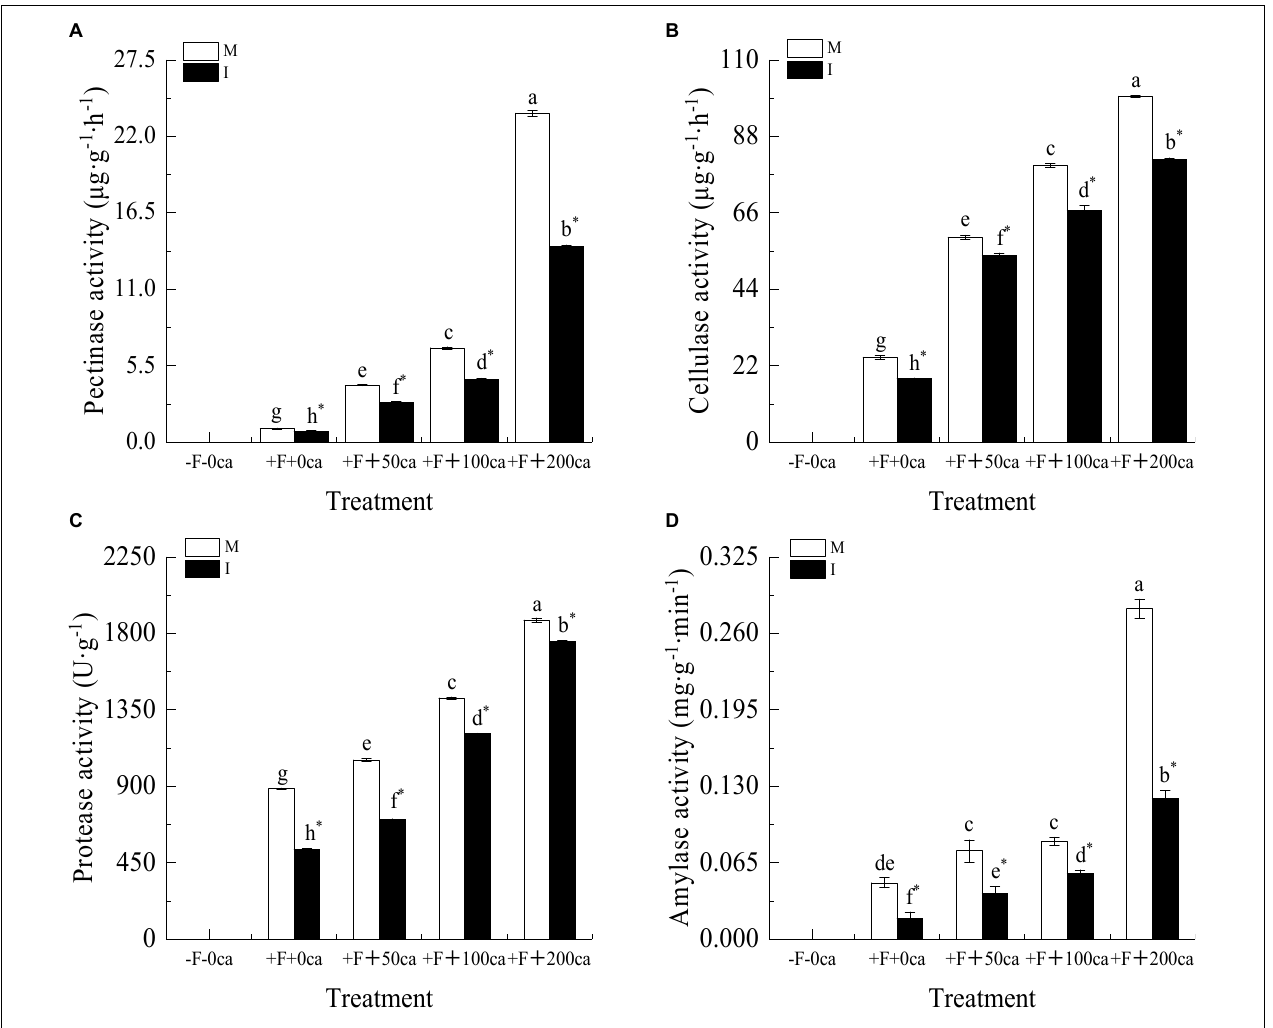
FIGURE 4 | Effects of FOF and cinnamic acid stress on stem cell wall degradation enzyme of faba bean and intercropping effect. (A) Pectinase, (B) cellulase, (C) protease, (D) amylase. Values in the figure are the mean ± standard error. Different lowercase letters after data indicate significant difference ( P < 0.05). ∗ Significant differences between monocropping and intercropping treatments with the same FOF and cinnamic acid levels ( P < 0.05). ca, cinnamic acid; FOF, Fusarium oxysporum f. sp. faba ; I, intercropping; M,